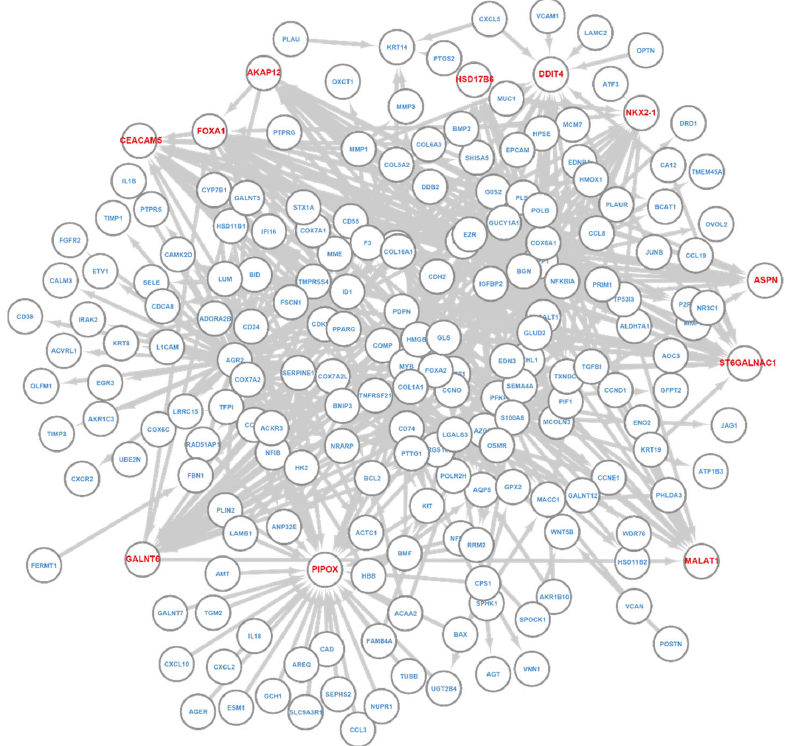
Figure 5. T ‐ GEM regulatory network of the last layer for LUAD. Nodes are informative genes and their associated Key genes. Links go from Key to Query genes. Genes with red color are hub genes. In summary, T ‐ GEM’s attention mechanism models a regulatory network of Query genes by Key genes, and the hub genes of the network of the top layer reveal important marker genes of different cancer types.